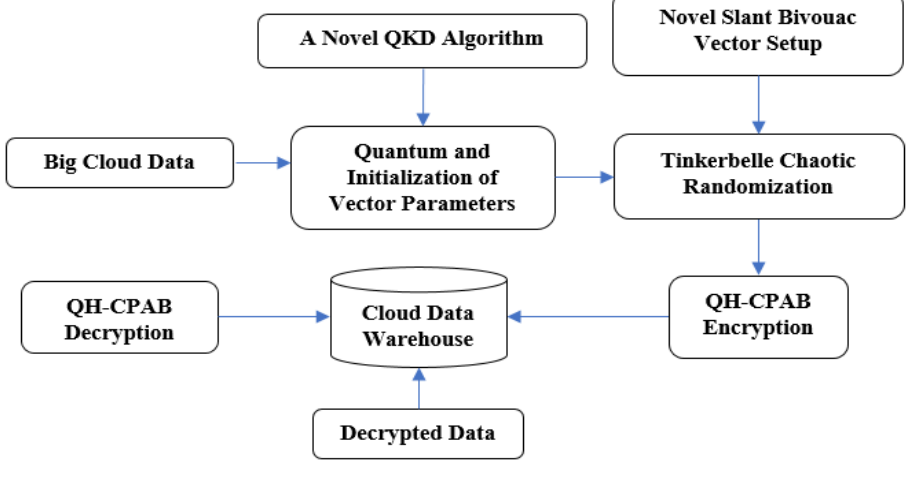
Figure 2. Proposed Model QHCP-ABE.